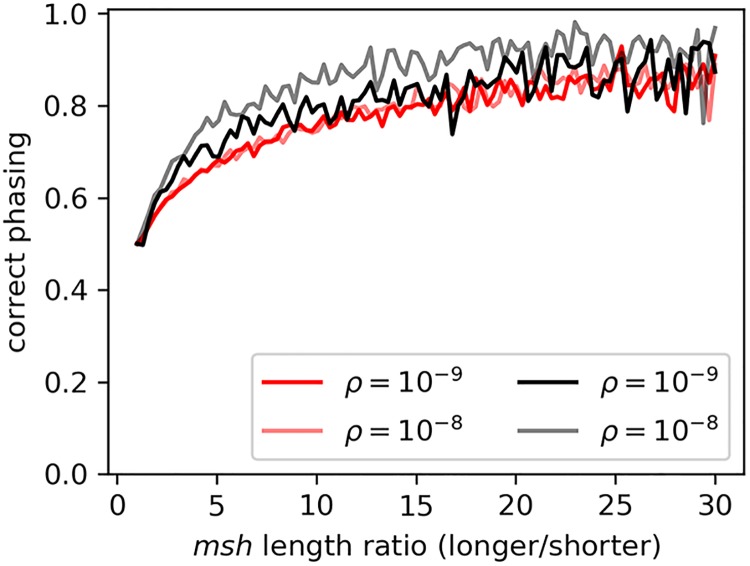
Frequency of a singleton variant residing within the shorter of two msh tracts.Accuracy of phasing singleton variants identified in simulations of n = 1000 (red) and of n = 100 (black) in 100 equal-width bins of the ratio of the longer to shorter msh tracts of the genotype carrying the rare variant.